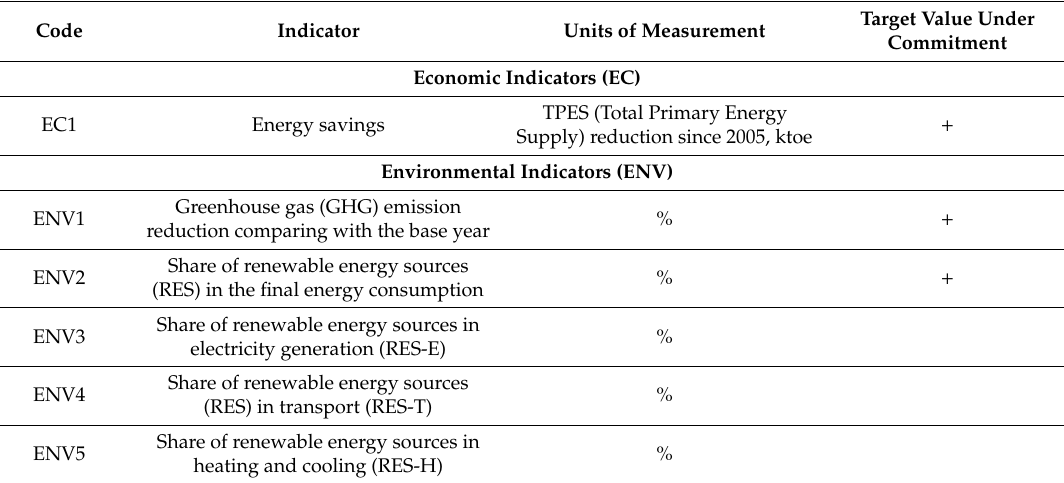
Table 1. Indicators of sustainable energy development. Source: created by the